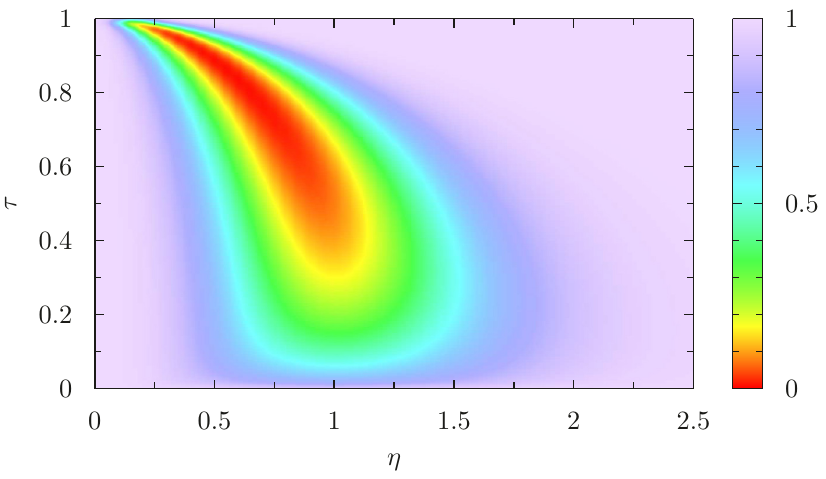
Figure 6. The parallel function at leading order: G ( η, τ ; η, − τ )